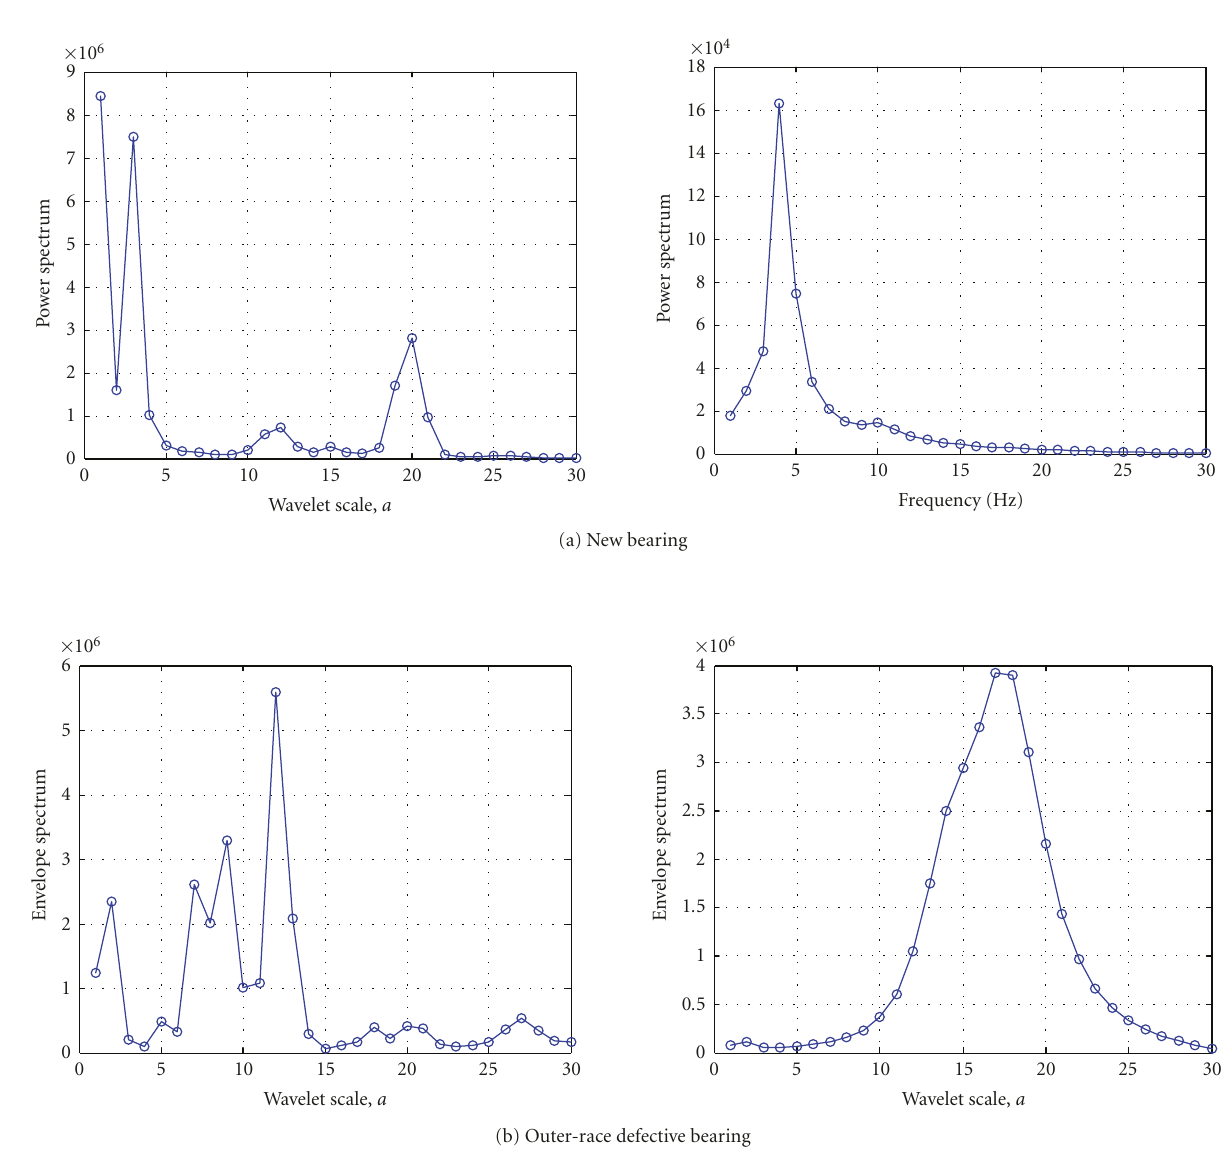
Figure 6: The wavelet-level power spectrum using (left column) Morlet wavelet, (right column) Laplace wavelet for new and outer-race defective